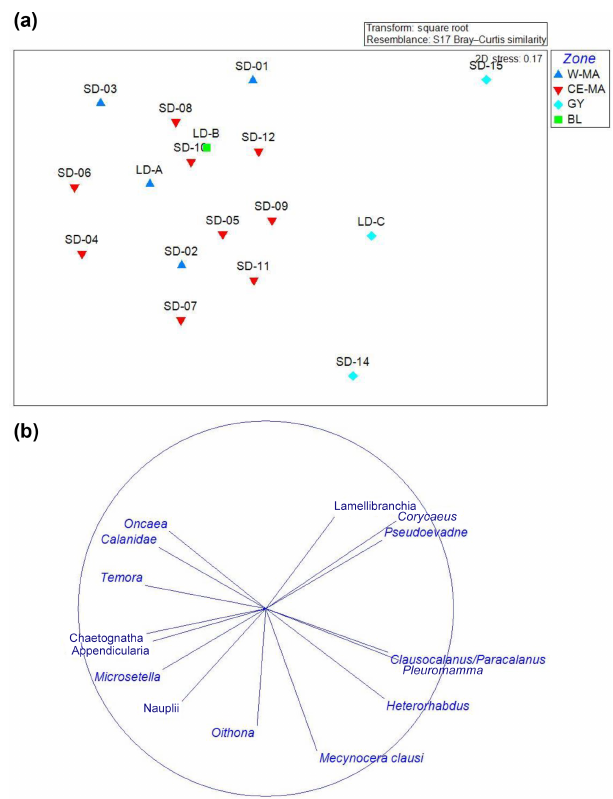
Figure 4. NDMS of the main zooplankton taxa ( > 0 . 1% abun- dance). (a) Plot of the stations with different colors between the regions identified with the environmental clustering (four regions: W-MA – western Melanesian archipelago; CE-MA – central and eastern Melanesian archipelago; BL – blooming conditions, station LD-B; GY – subtropical gyre). (b) Plot of the